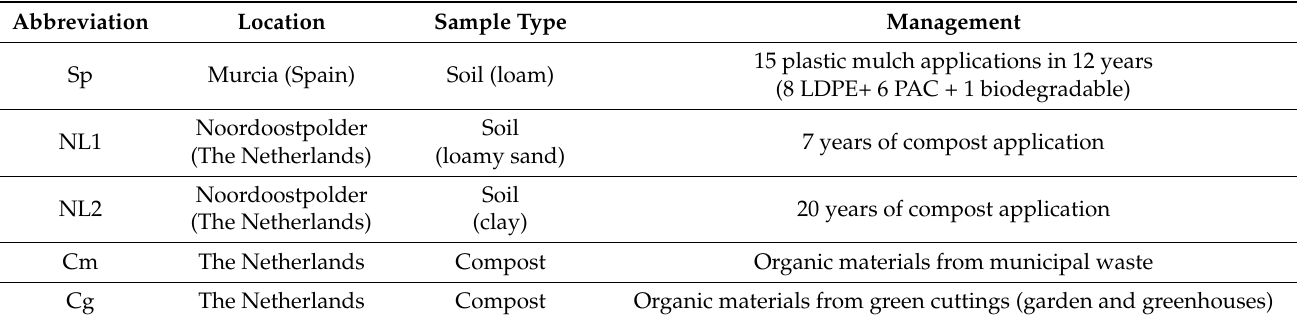
Table 1. Sampling design description and